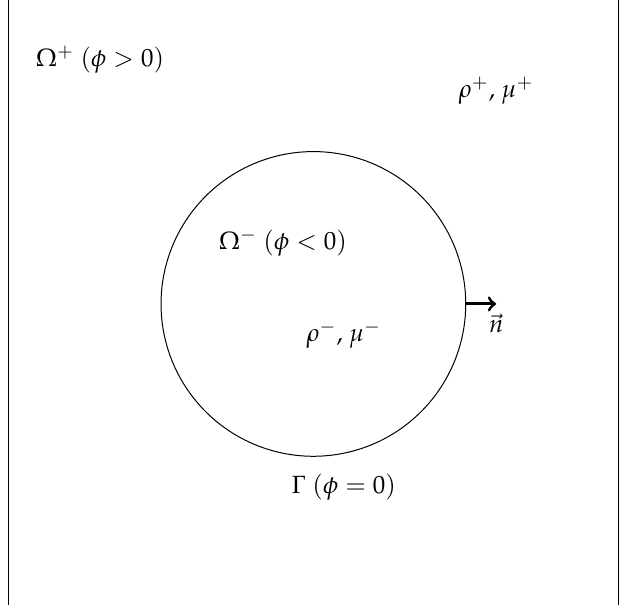
Figure 1. Sketch of the computational